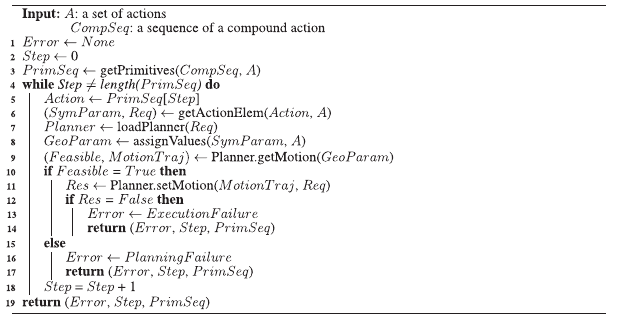
Algorithm 1 Motion generator algorithm.